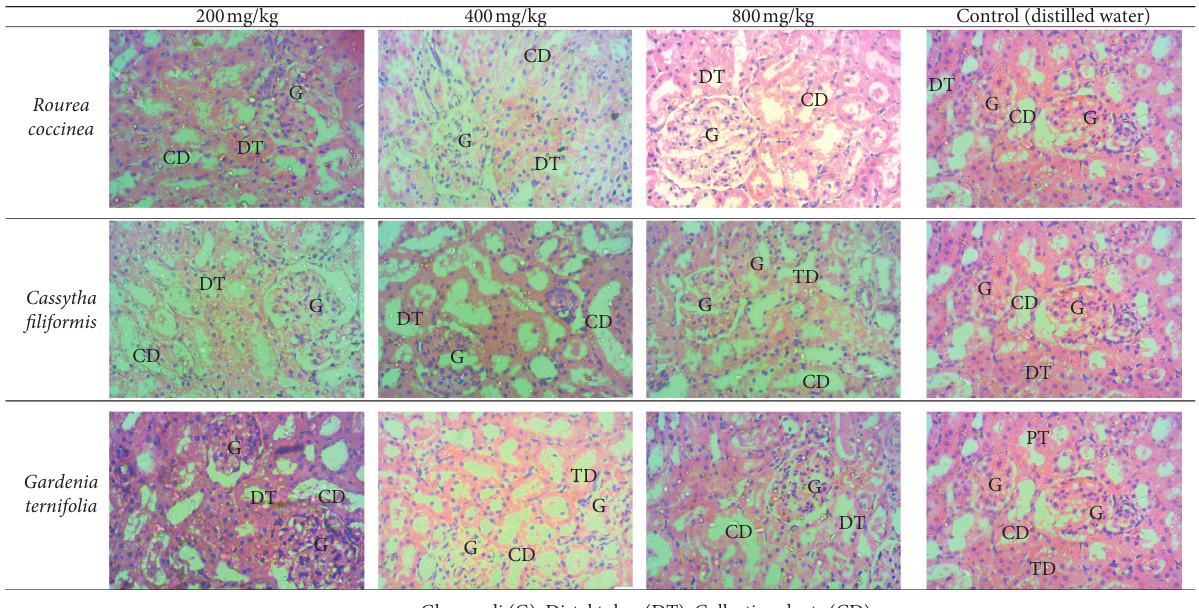
Figure 5: Kidneys histology of treated and untreated rats ( × 400